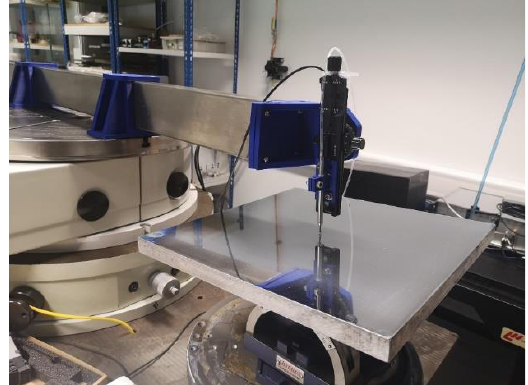
Fig. 4. Metrology during process development.